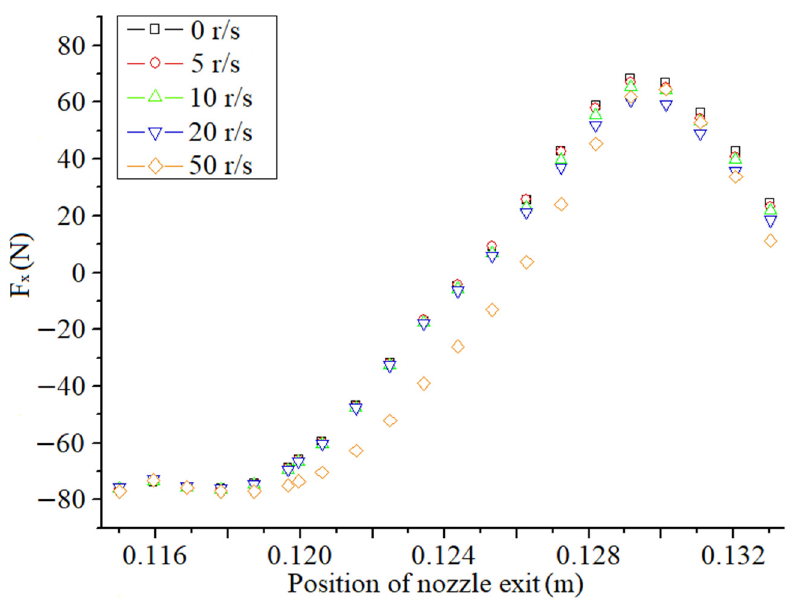
Figure 20. Thrust distribution along the right nozzle exit at different rotational angular velocities.